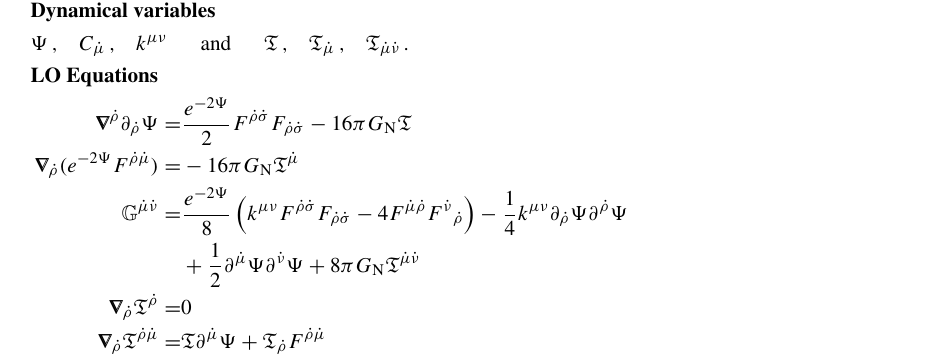
Table 4 The equations for GR at leading order in the large c expansion